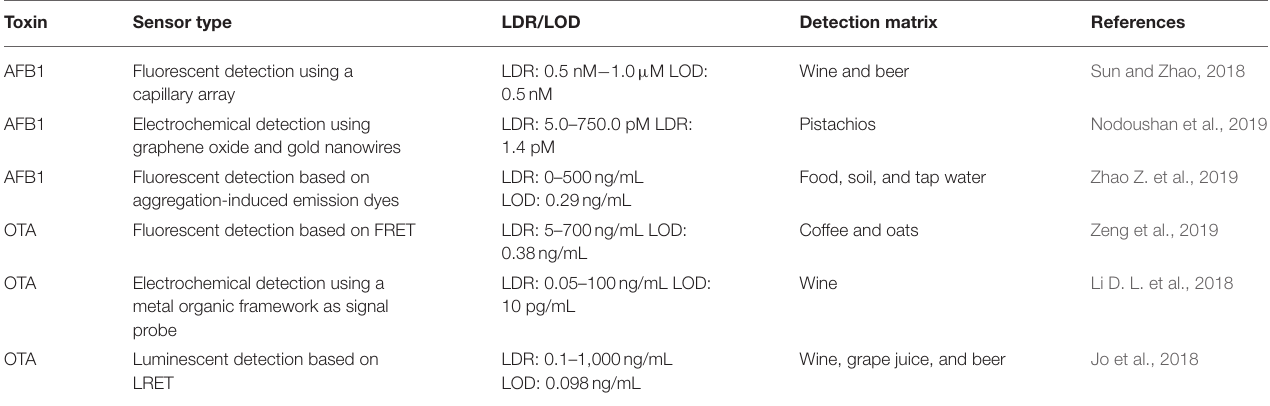
TABLE 4 | Aptamer-based biosensors for the detection of agricultural toxins.